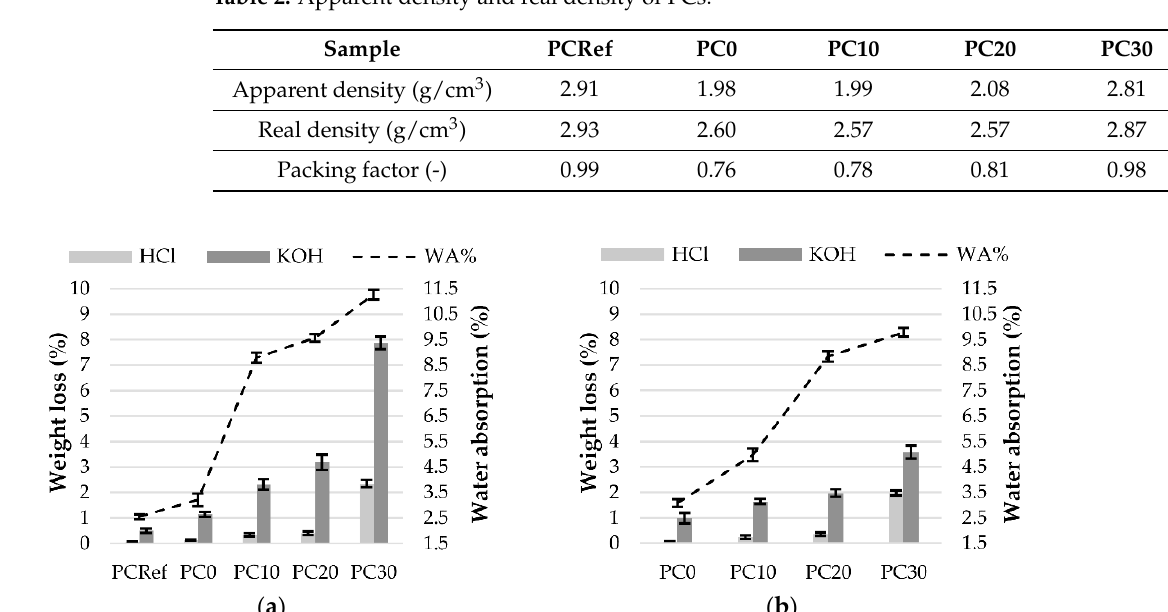
Figure 3. RGA compaction at increasing content of fine fraction: ( a ) 0 wt%, ( b ) 10 wt%, ( c ) 20 wt%, ( d ) 30 wt%. SEM micrographs at 400× magnification. Table 2. Apparent density and real density of PCs.